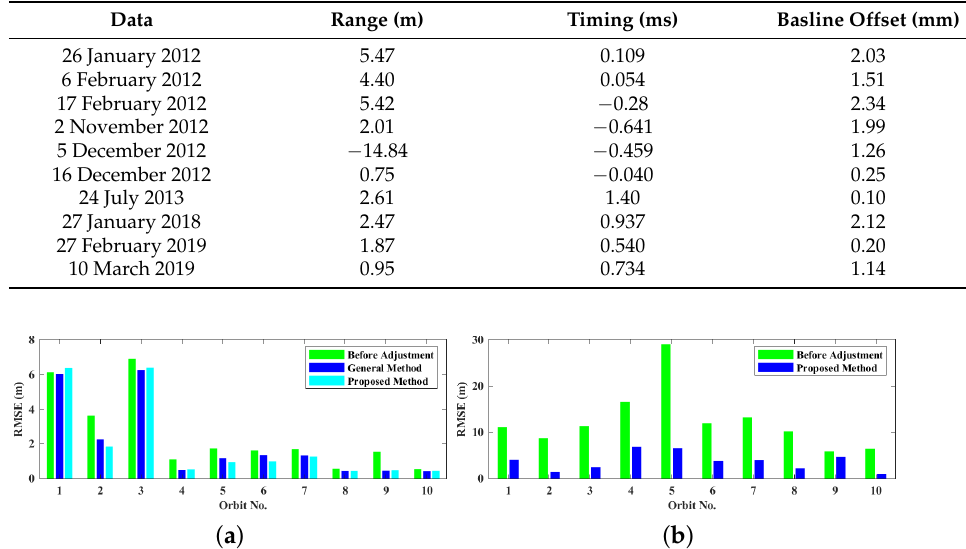
Table 3. The adjustment results of InSAR parameters. The table is listed by track.